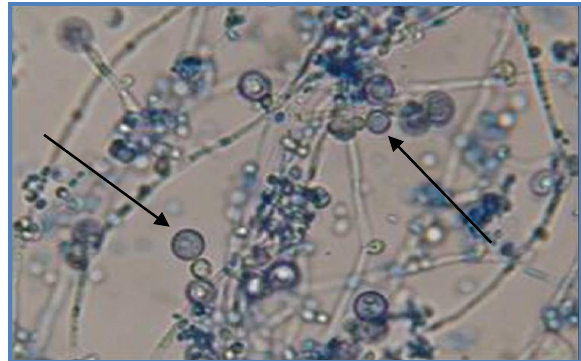
Figure, 2: Chlamydospores of Candida albicans.